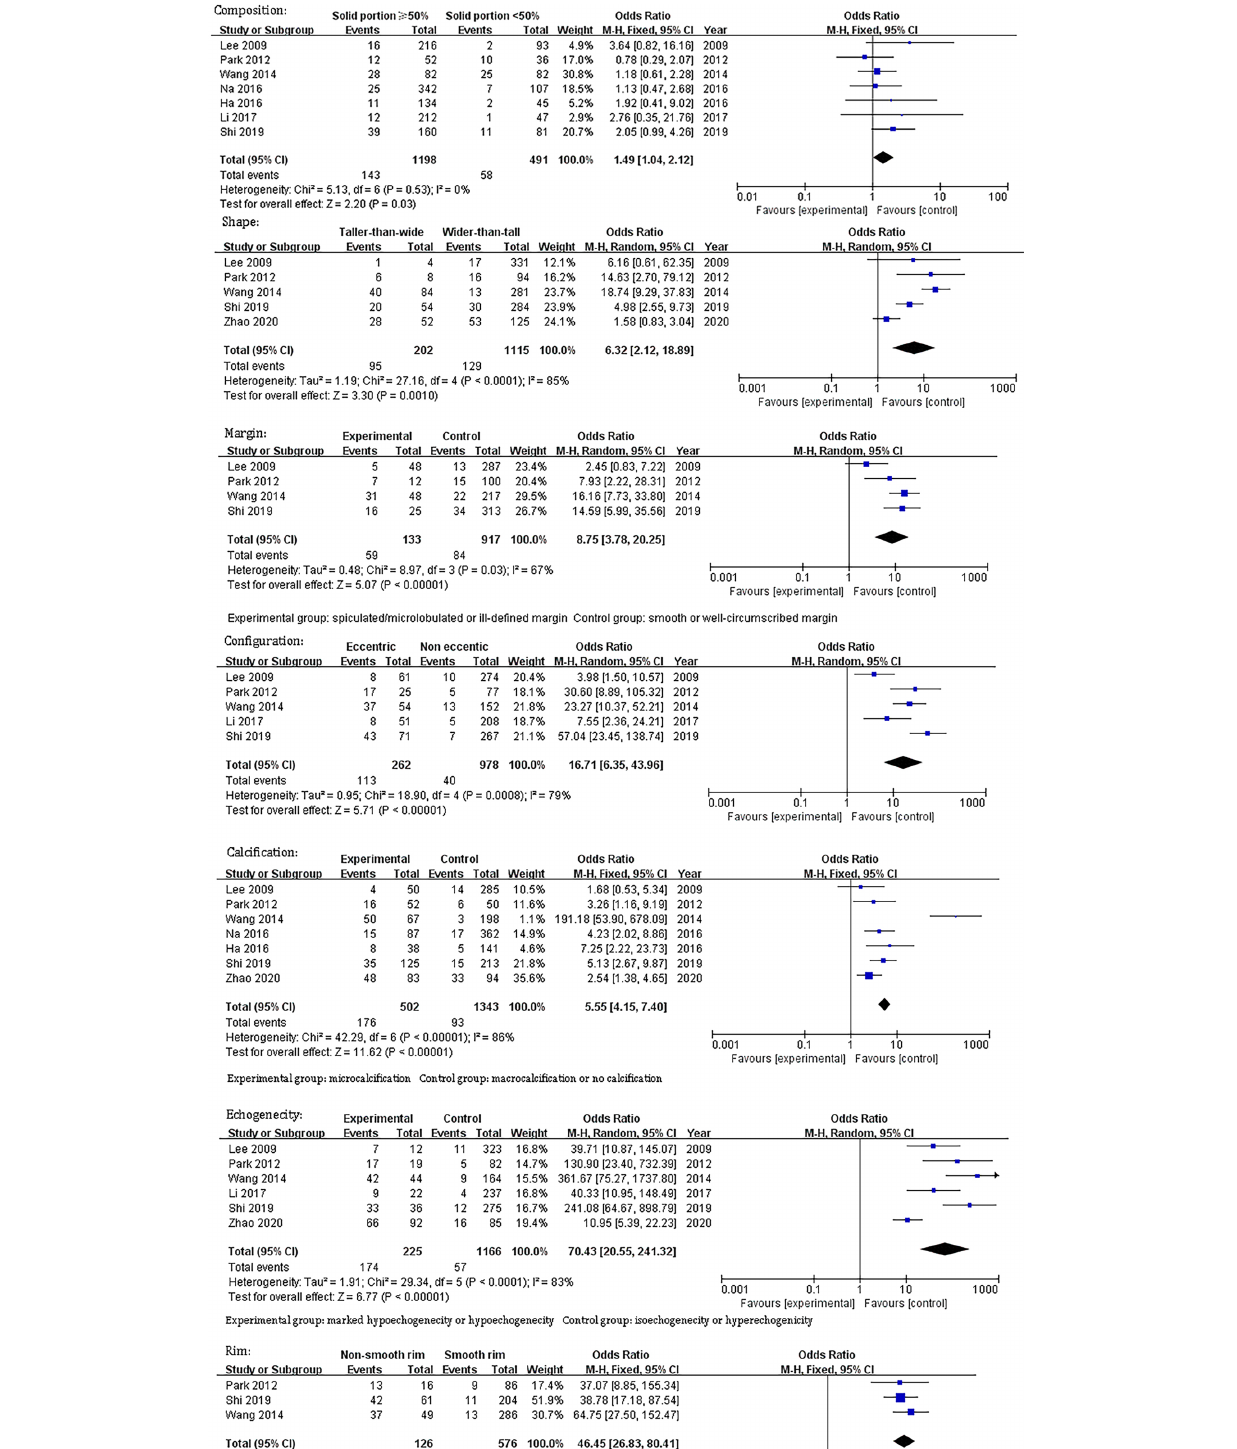
Frontiers in Endocrinology |